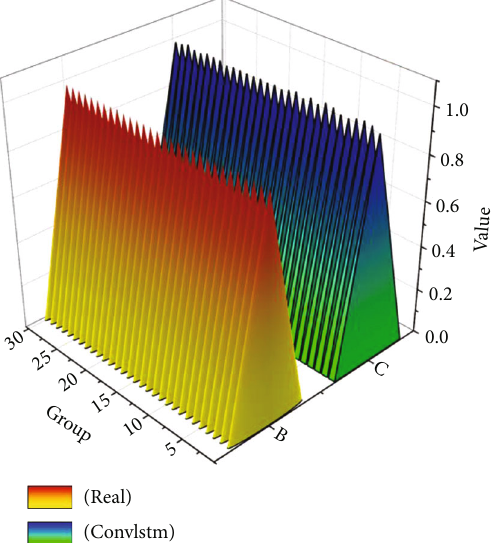
Figure 6: Predicted value and actual value distribution of English grammar teaching characteristics in English